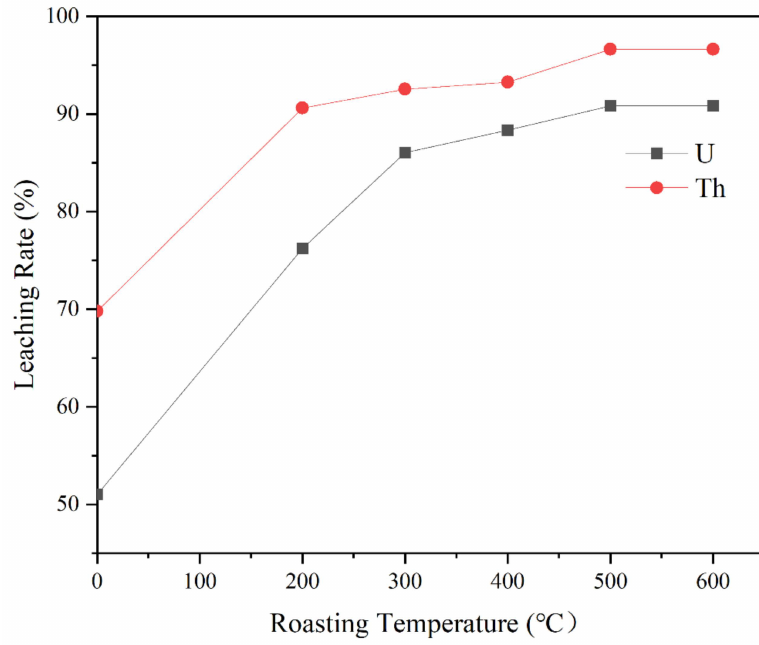
Figure 4. Effects of roasting temperature on uranium and thorium leaching.